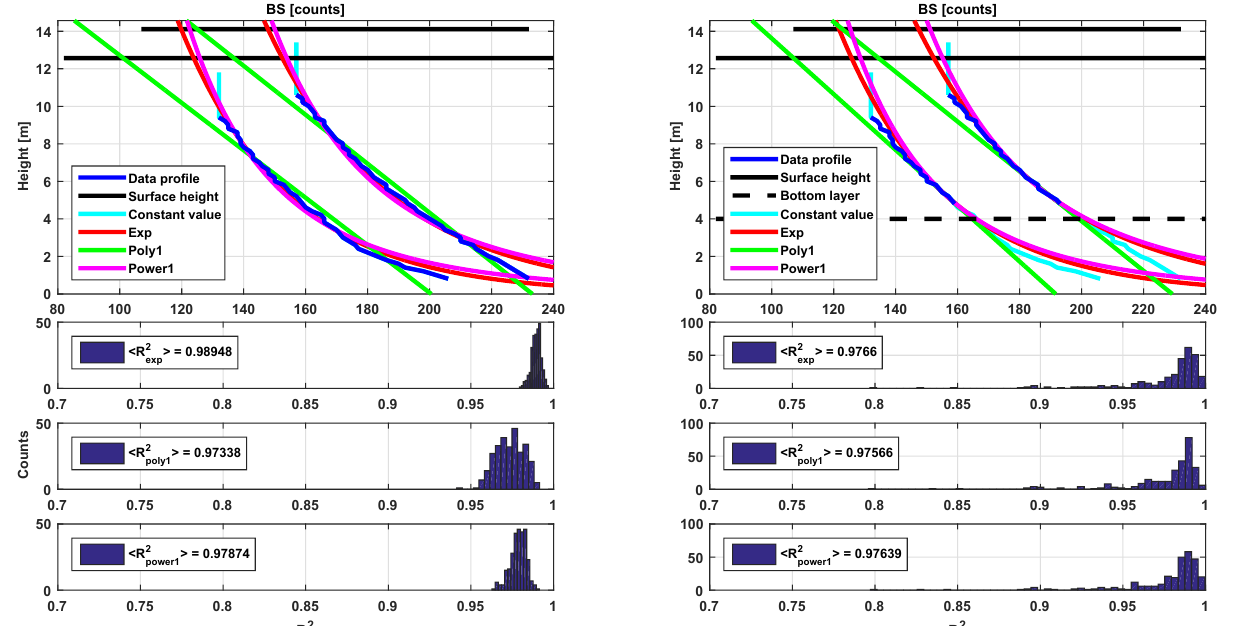
Figure 5. Selected acoustic backscatter profiles during low water and during flooding; top left: extrapolation through the whole water column; top right: extrapolation through the reduced water column. The coloured profiles show the results of the different extrapolation methods (cyan: constant extrapolation; red: exponential extrapolation; green: polynomial extrapolation; magenta: power extrapolation). Black line: surface layer and black dotted line: lower layer. Bottom panels: histograms of the corresponding R 2 values (from every profile) for the entire period; left: for the whole water column, right: for the reduced water column.